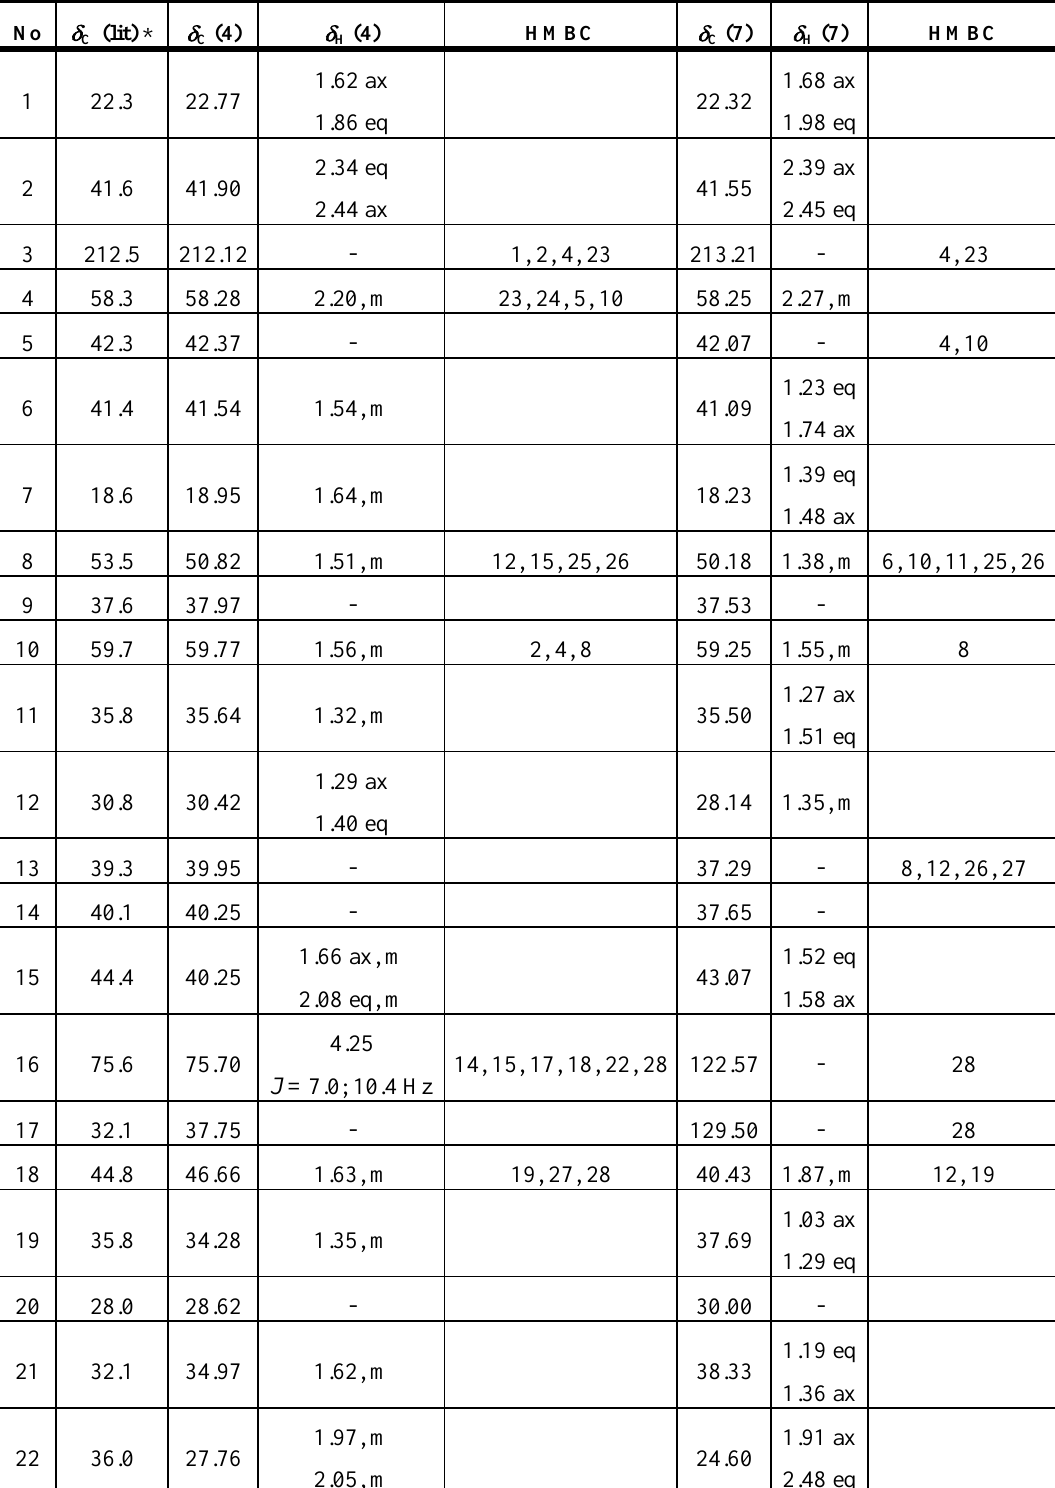
Table 1 . 1 H (400 MHz) and 13 C (100 MHz) NMR spectral data of 16 α - ) and 3-oxo-16-methylfriedel-16-ene ( 7 ) ( δ hydroxyfriedelin ( 4 ) ( δ values, Py-d 5 values, CDCl ) * (Literature data of 16 -hydroxyfriedelin) 3